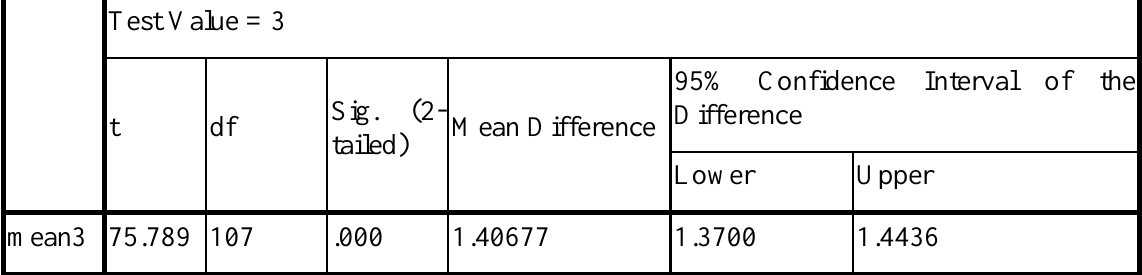
Figure 17. The results of t-test for the data of hypothesis